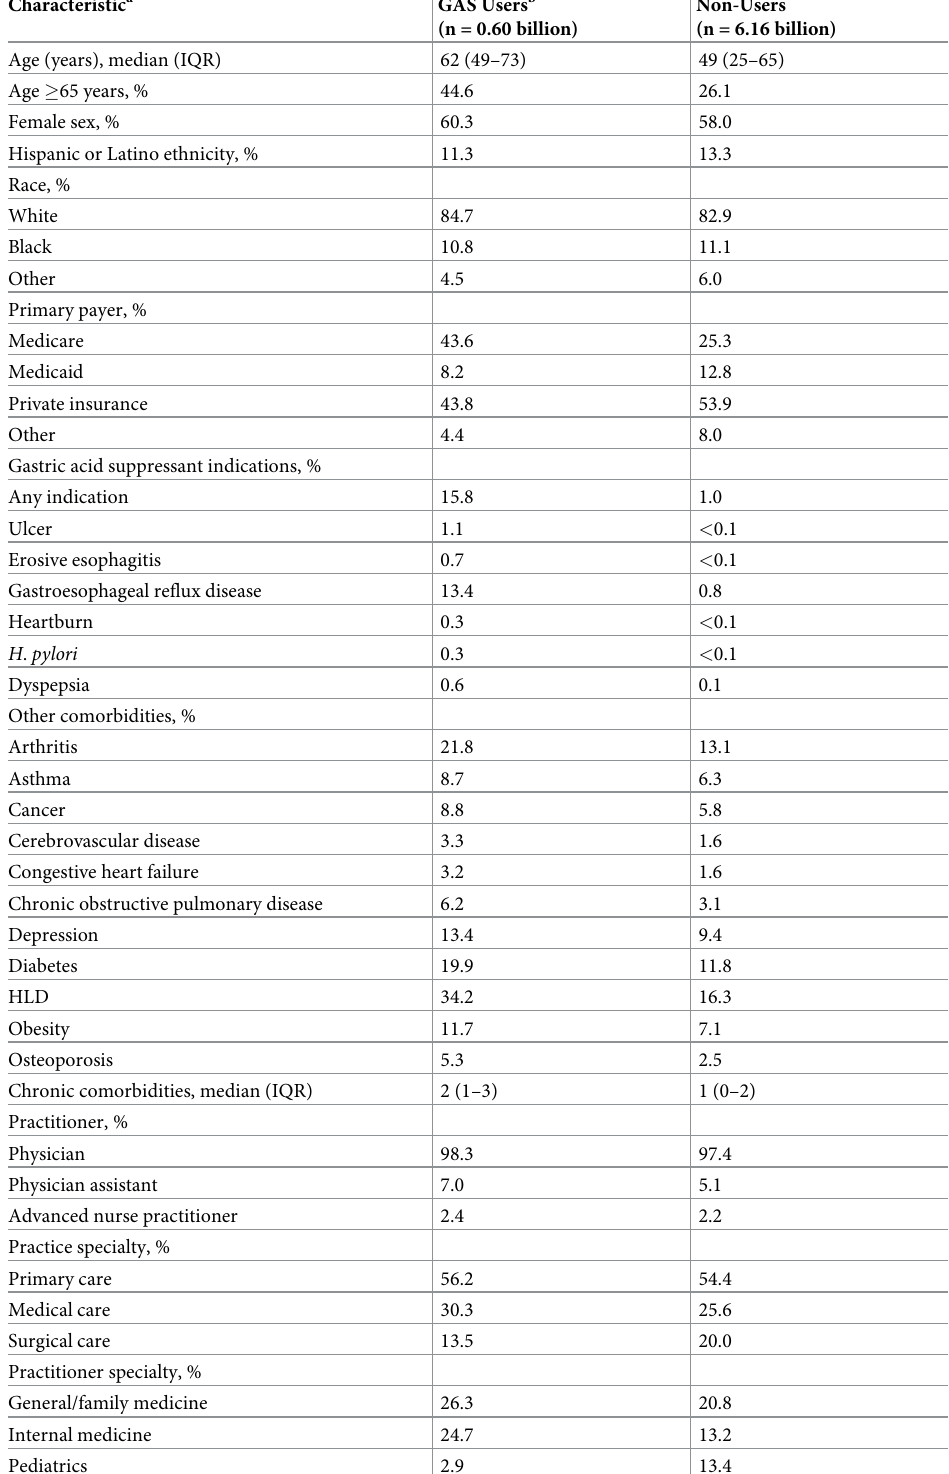
Table 1. Baseline